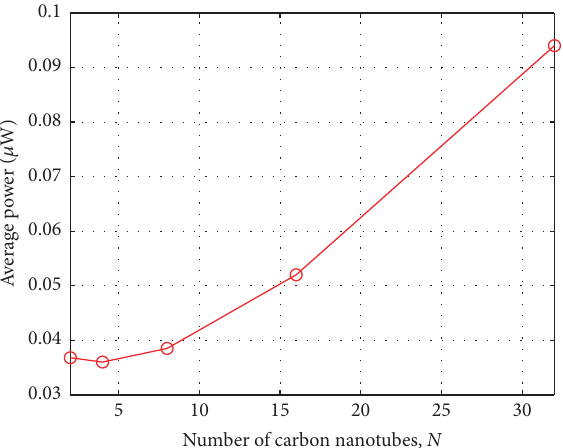
Figure 5: Effect of CNT number on the power consumption.